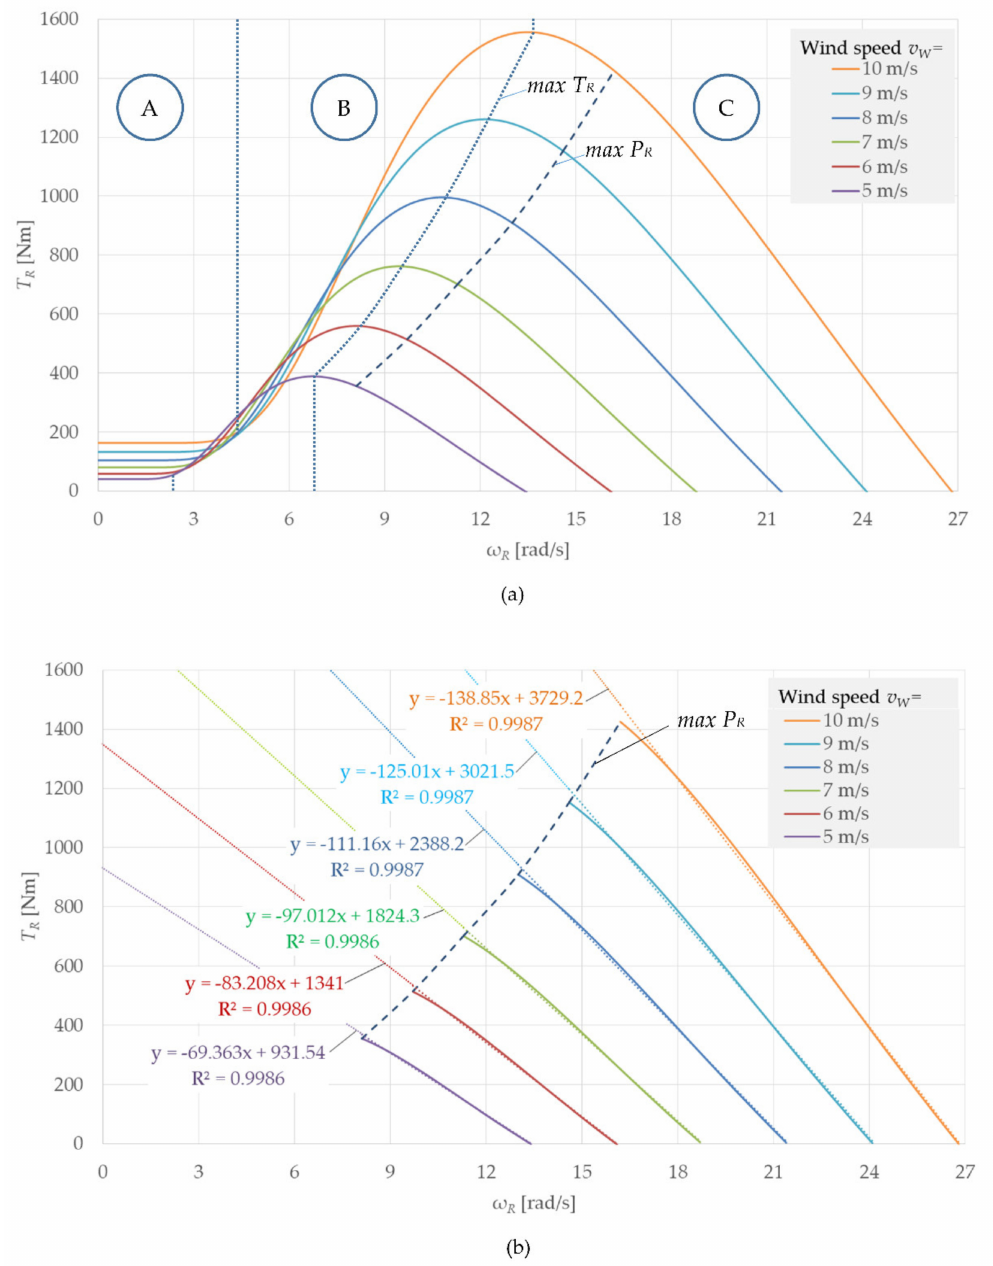
Figure 5. The influence of wind speed on the mechanical characteristic of a wind rotor: ( a ) mechanical characteristic zones; ( b ) linearized active sector of mechanical